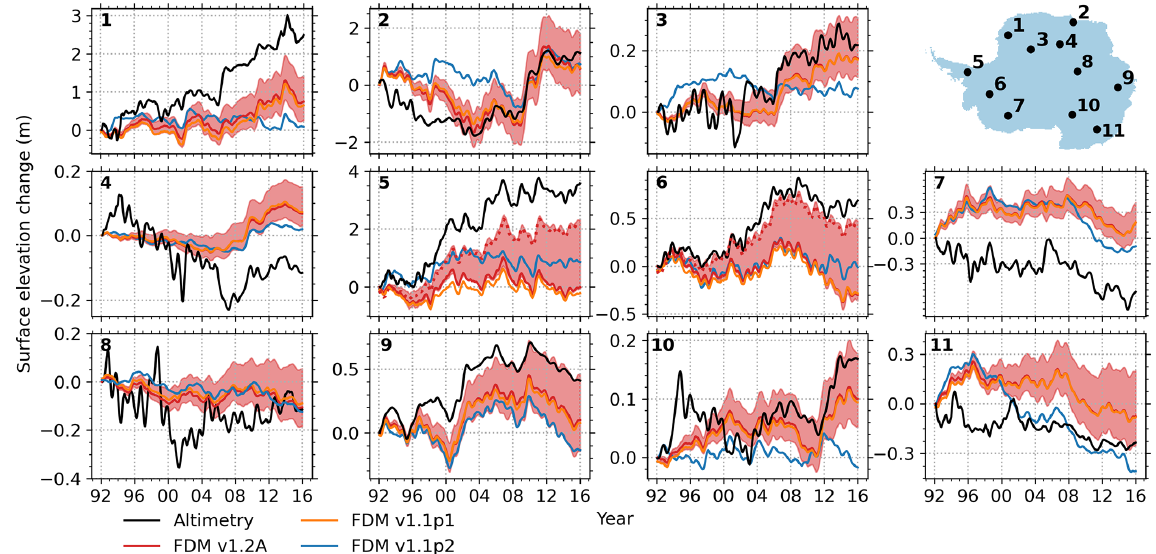
Figure 9. Time series of the altimetry observations and modelled elevation change for 11 locations over the period 1992–2015. The time series have been smoothed using a 6-monthly moving average window. The modelled elevation change includes FDM v1.2A, FDM v1.1p1 and FDM v1.1p2. The number of each panel corresponds to the numbered locations on the maps. The red-shaded areas indicate the total uncertainty from the sensitivity analysis. The dotted red lines in panels (5) and (6) indicate the surface elevation change from the spin-up T s , ˙ b